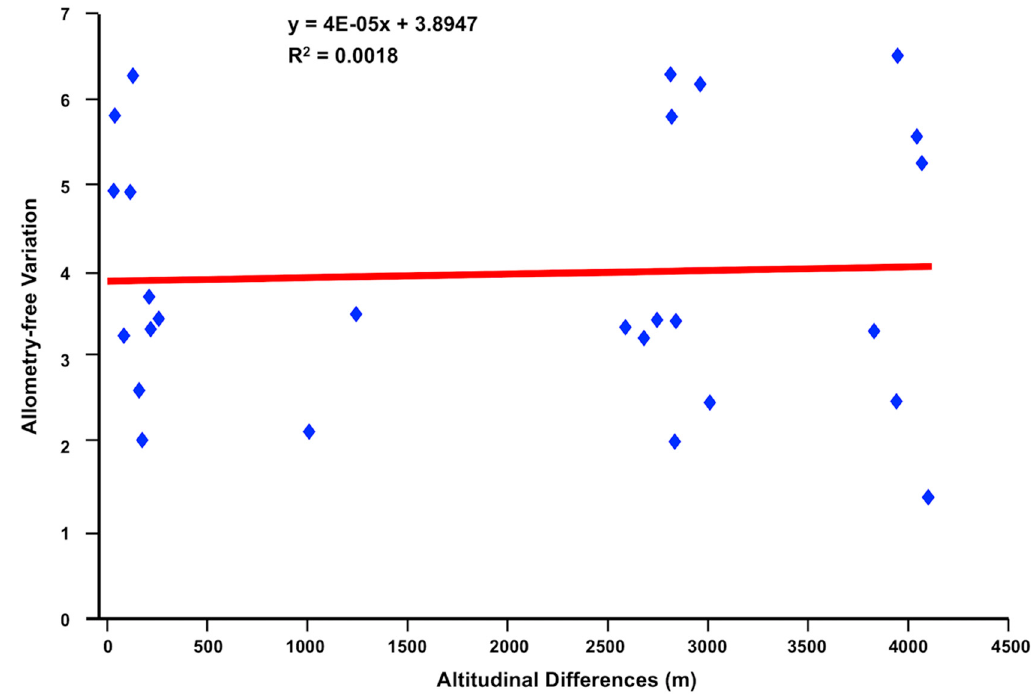
Figure 5. Plots of the pairwise Mahalanobis distances derived from allometry-free variables (vertical axis) against the corresponding altitudinal differences. Straight lines represent the linear regression prediction.